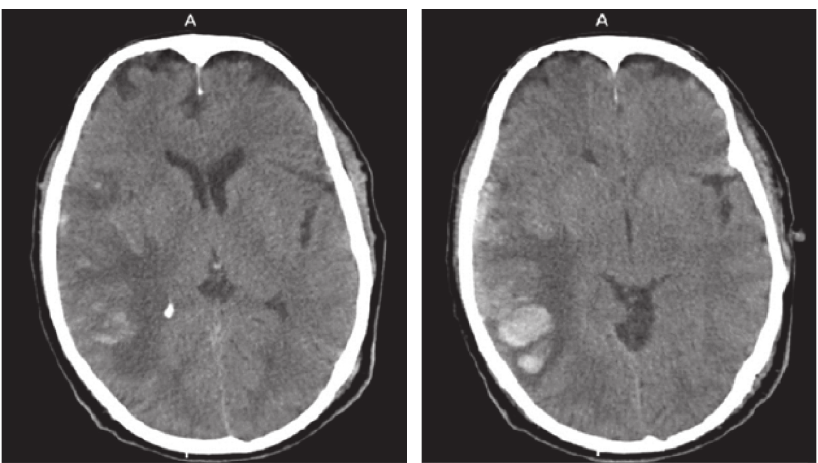
Figure 2: Second brain CT scan.